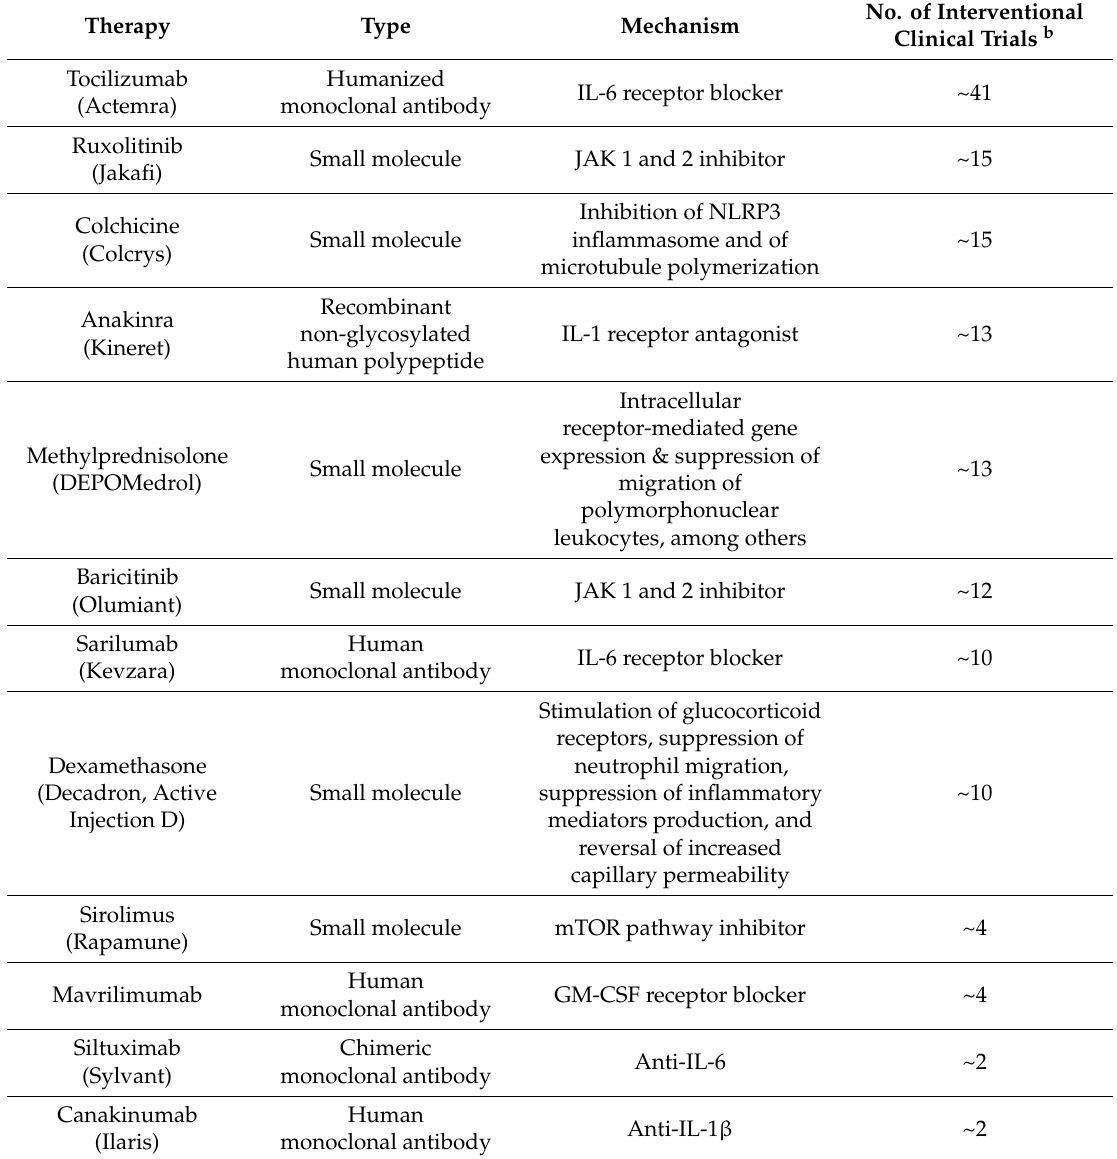
Table 2. Most frequently evaluated anti-inflammatory / immunomodulatory drugs in clinical trials